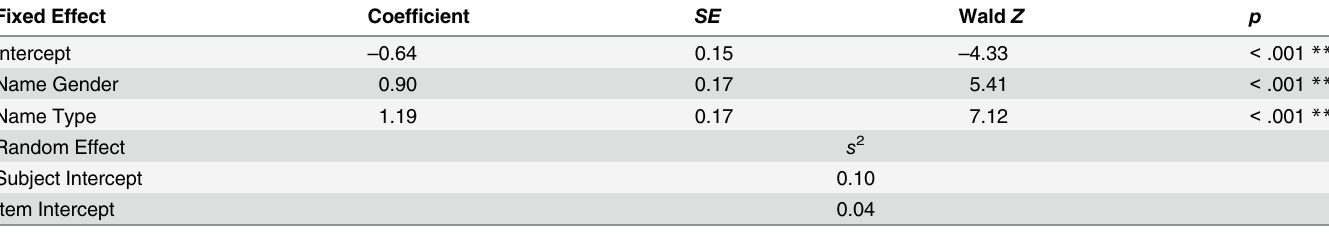
Table 1. Summary of logistic regression predicting the likelihood of a round silhouette